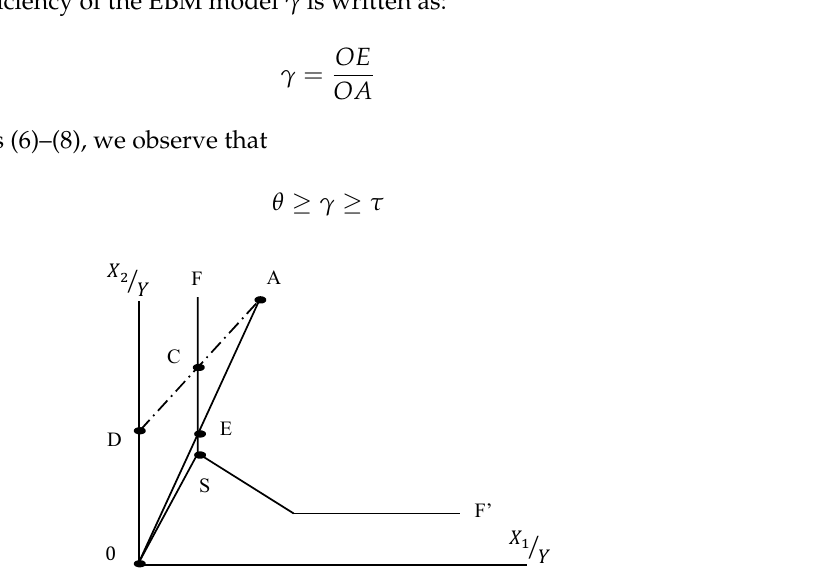
Figure 2. Comparison of Charnes, Cooper, and Rhodes (CCR), slacks-based measure (SBM), and epsilon-based measure (EBM) data envelopment analyses.